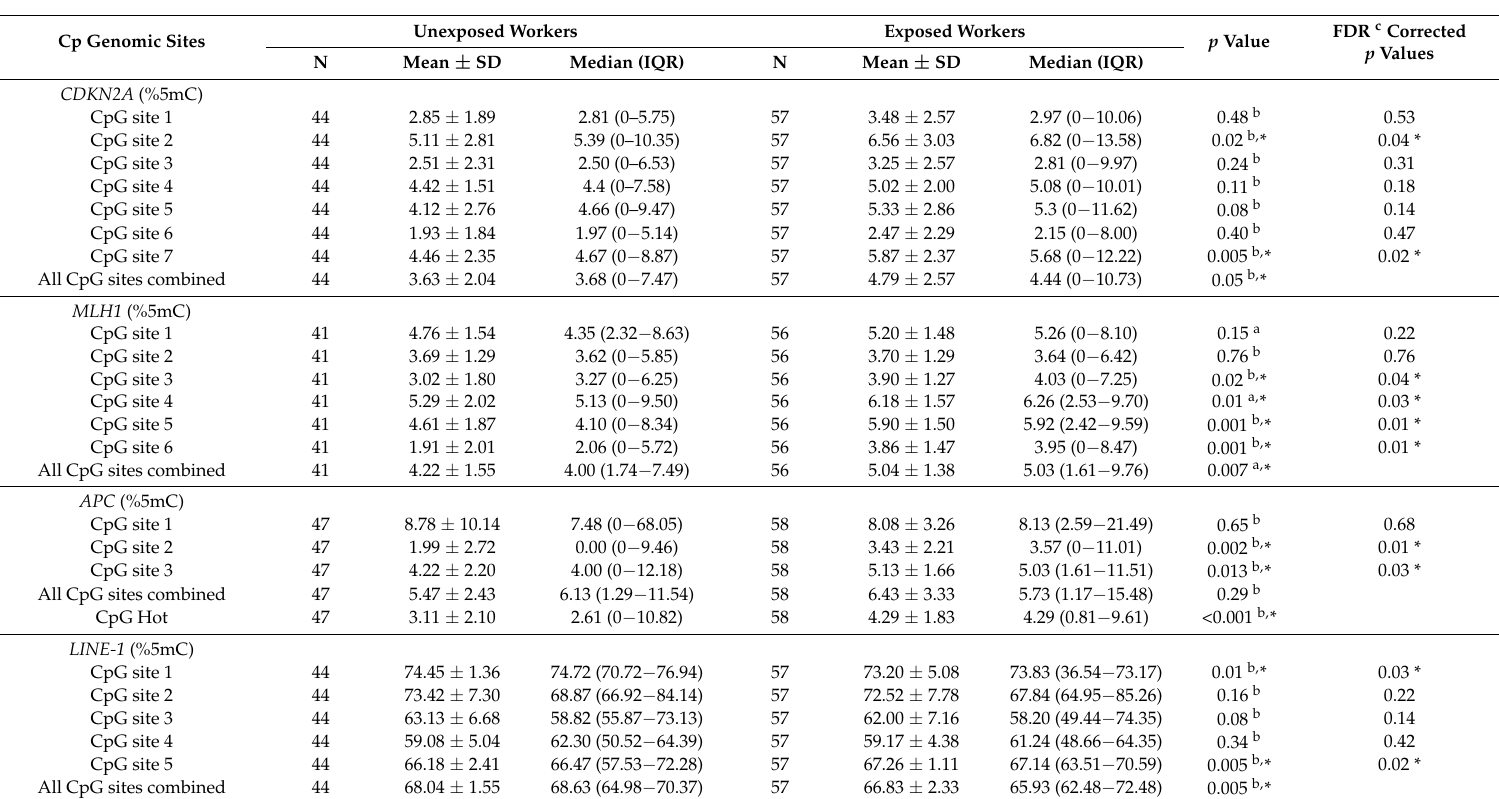
Table 2. Evaluation of the DNA methylation profiles in the promoter regions of the CDKN2A , MLH1 , and APC genes and repetitive sequence LINE-1 in construction workers and